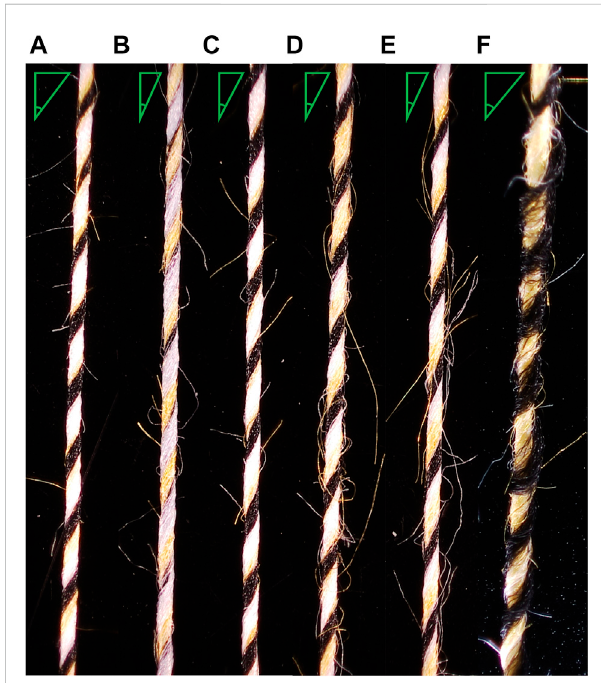
FIGURE 7 Comparisonofthestructuralappearanceofthedifferentscheme compound yarns: (A) CY-A spun yarn; (B) CY-B spun yarn; (C) CY-C spun yarn; (D) CY-D spun yarn; (E) CY-E spun yarn and (F) CY-F spun yarn.